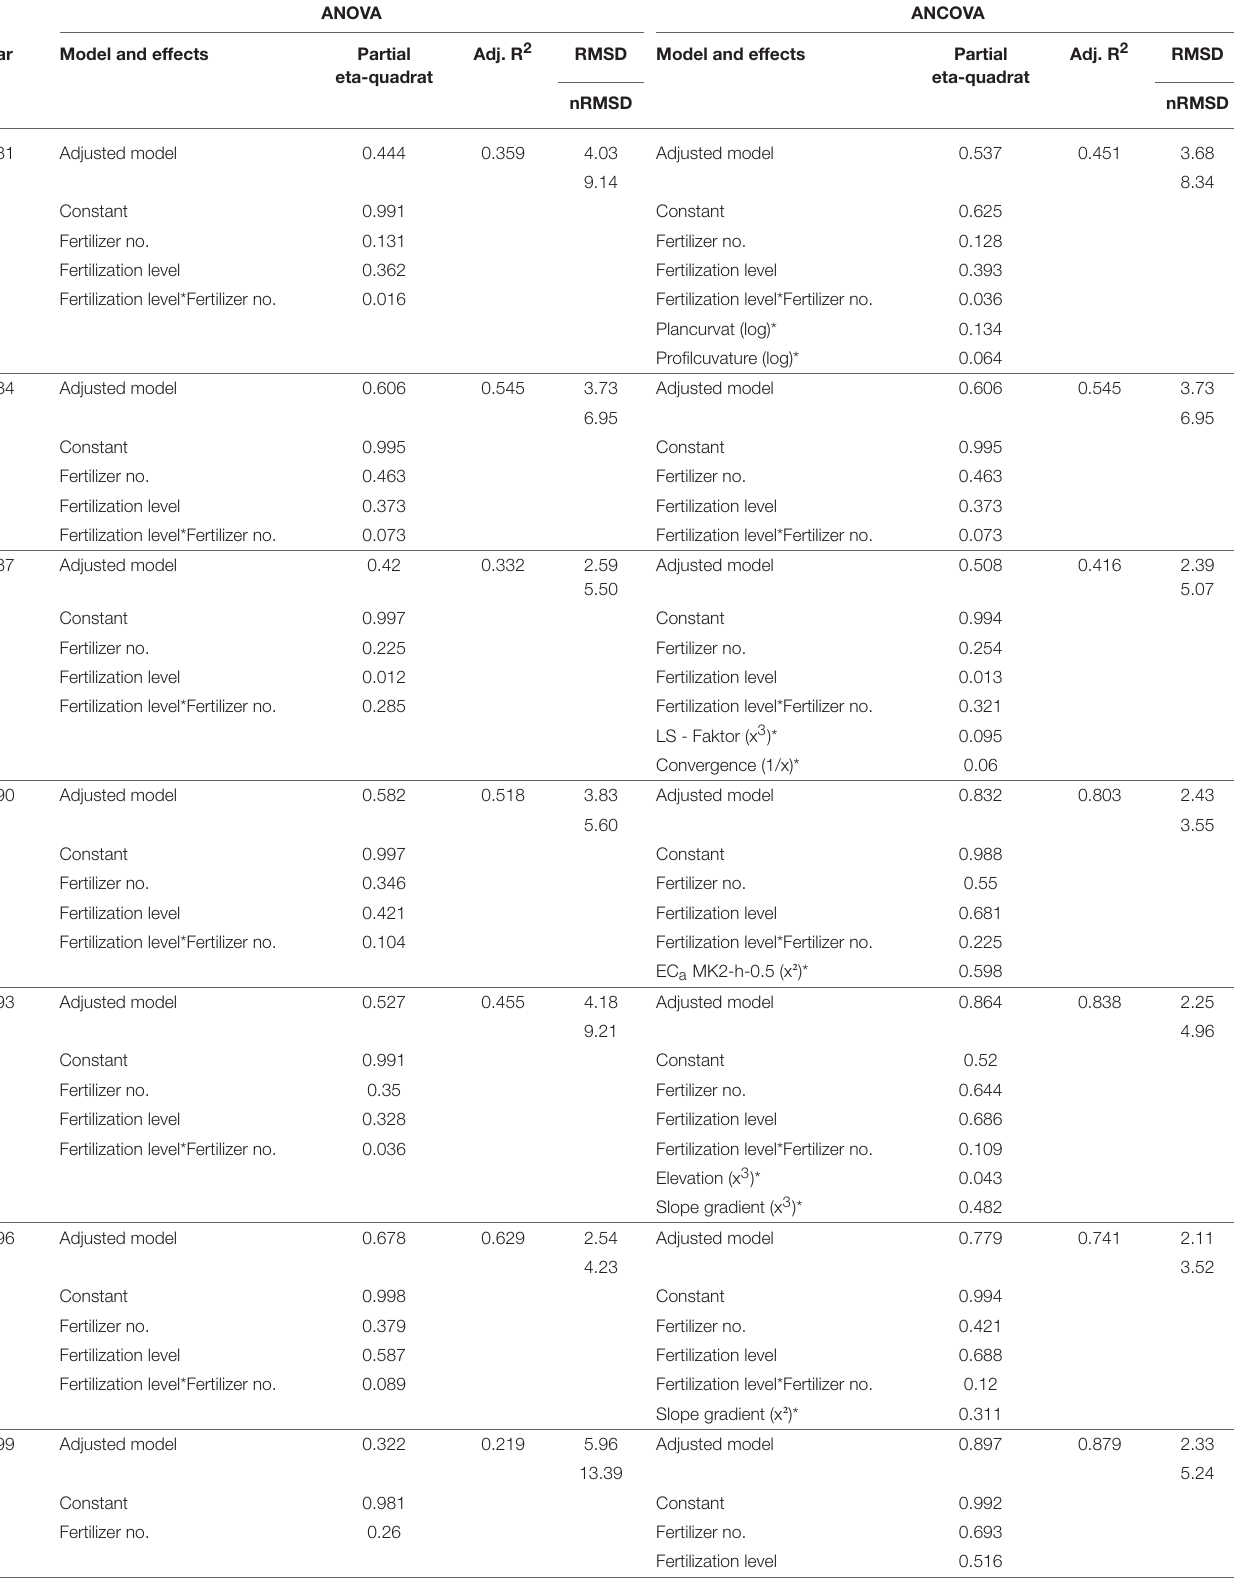
TABLE 8 | Simulation of the annual yield from 1981–2013 with ANOVA and ANCOVA (further information is given in Supplementary Table 5